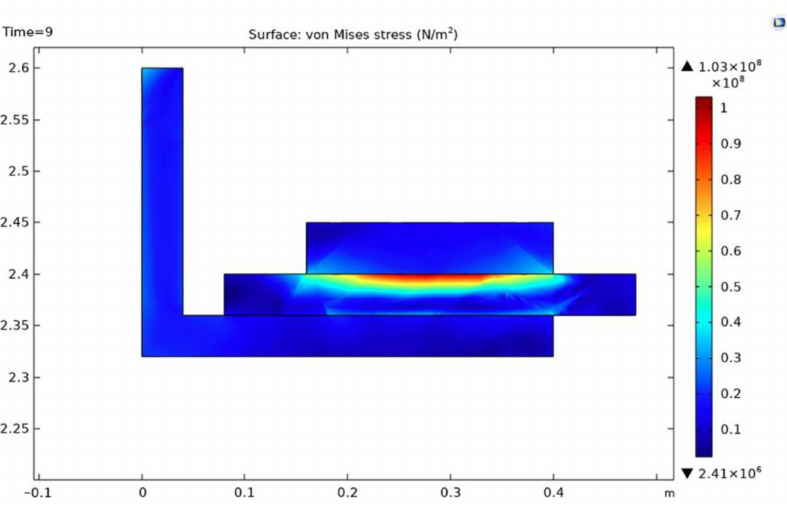
Figure 15. Cross-section of the von Mises effective stress at t = 9 s. The variation of the von Mises stress in time is presented using the data sets introduced, along the Cut Line 3D data set (Figure 16) and along the linearized circumference of the Parametrized Curve 3D data set (Figure